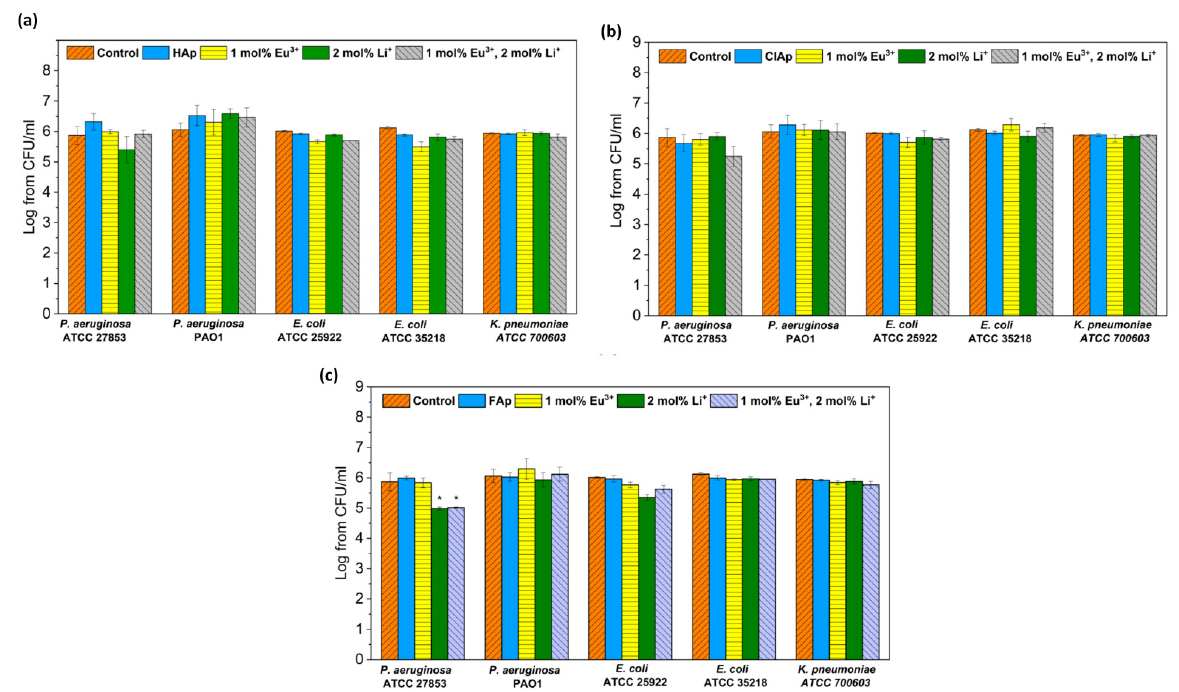
Figure 15. Antibacterial effect of hydroxyapatites ( a ), chlorapatites ( b ) and fluorapatites ( c ) doped with Eu 3+ and Li + ions (concentration of 100 µg/mL) against Gram-negative strains: P. aeruginosa , E. coli and K. pneumoniae ; mean ± SD, n = 3; *—statistically different from the control ( p < 0.05).